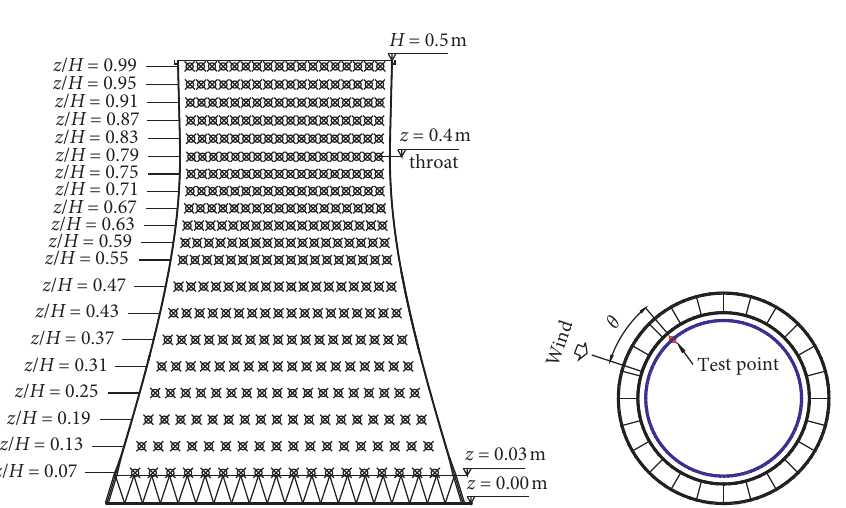
Figure 3: Pressure taps arrangement and the definition of θ